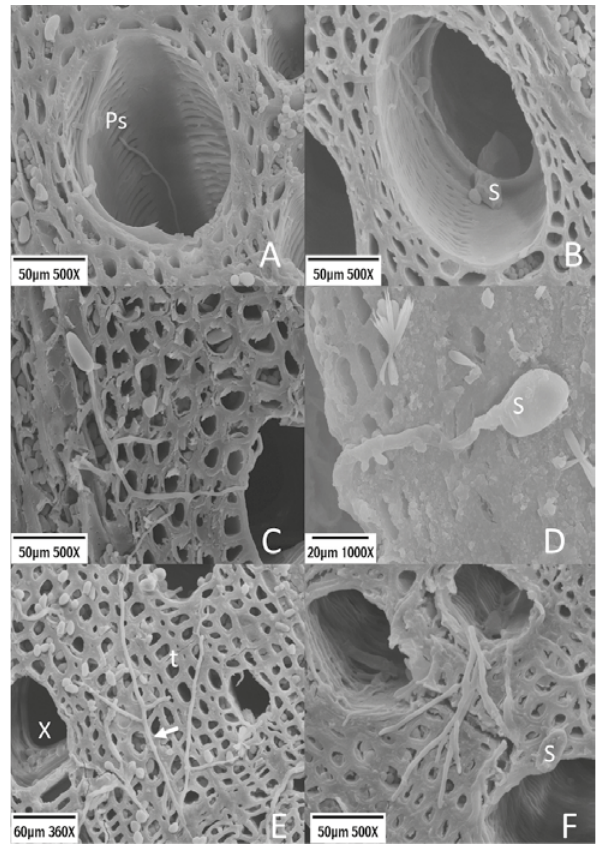
Figure 7. SEM of cross-sections of grapevine stems inoculated with spores of Lasiodiplodia gilaniensis (A and B), Diplodia seriata (C and D) or D. corticola (E and F), at 24 h after inoculation. A, hyphae entering the pits to colonize adjacent tissue. B, spores and hyphae growing in and out of a xylem vessel. C and D, hyphae entering the xylem vessels and tracheids. E, hyphae entering tracheids. F, gemi- nated spore with hyphae entering and branching in and out of a xylem vessel. X) xylem vessel; t) tracheids; S) spore; Ps) pits.